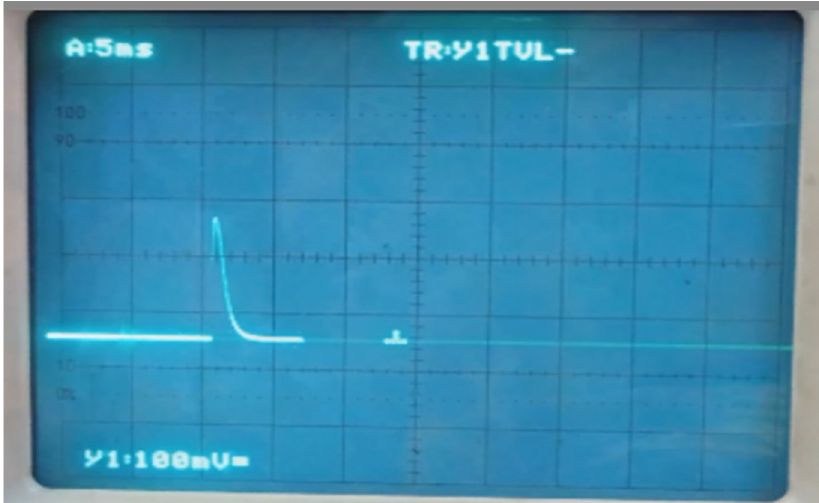
Figure 6. Pulse shape i 1 at bench experiment [own elaboration], graph that visually show the dependence of the corresponding functions on the arguments.